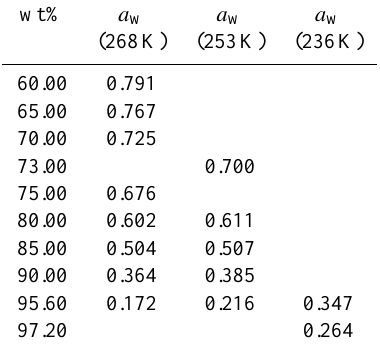
Table 11. Water activity (a w ) measurements ∗ of aqueous M5 so- lutions from EDB hygroscopic growth curves evaluated at the indi- cated weight fractions.